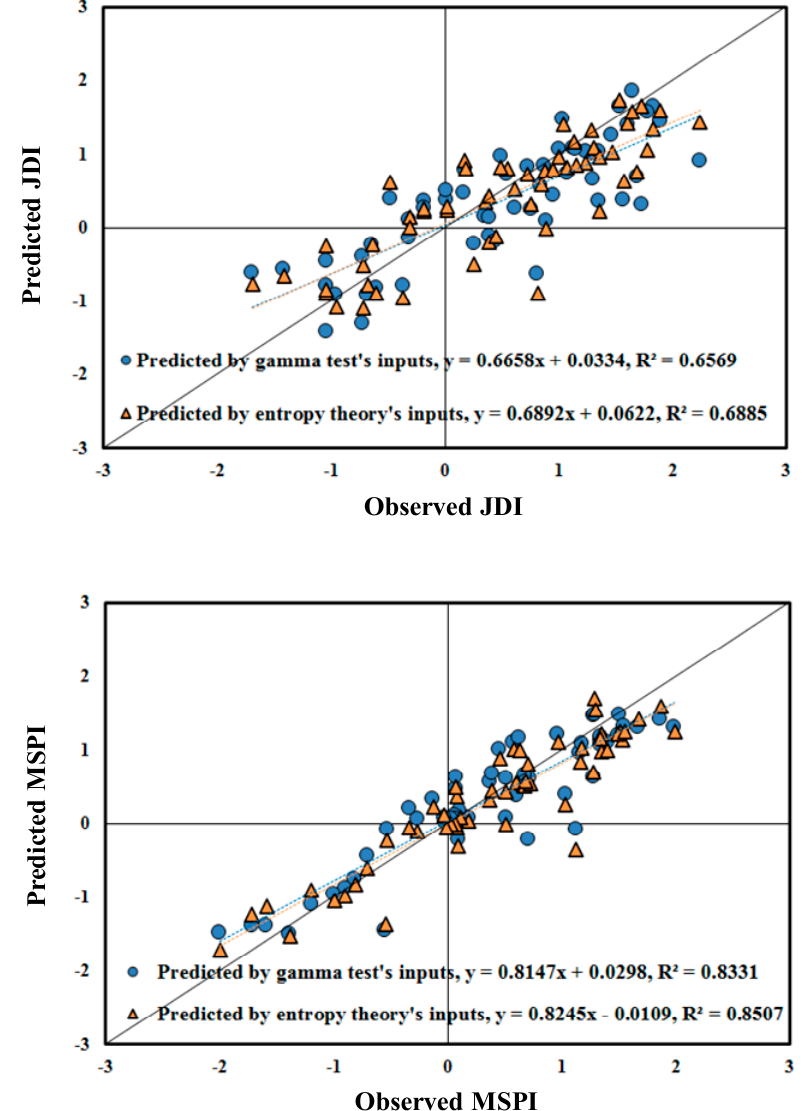
Figure 5. Scatter plots in comparing the performances of the gamma test and entropy theory for MSPI and JDI prediction (Marvast station).